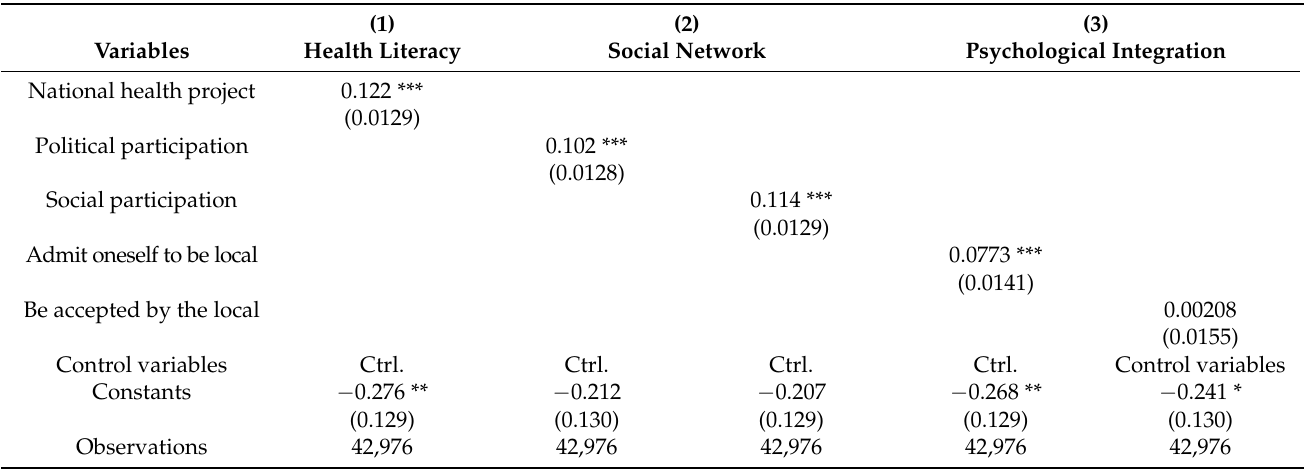
Table 8. The impact of public health education and intermediary